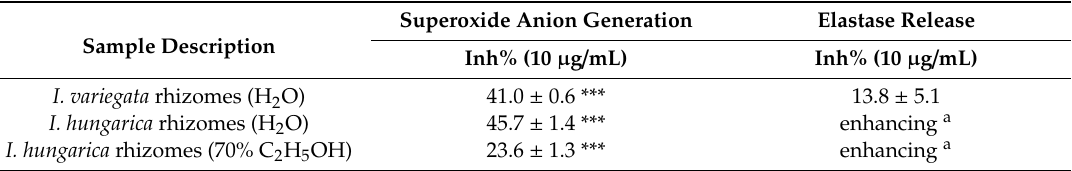
Table 6. Anti-inflammatory activity of Iris sp.